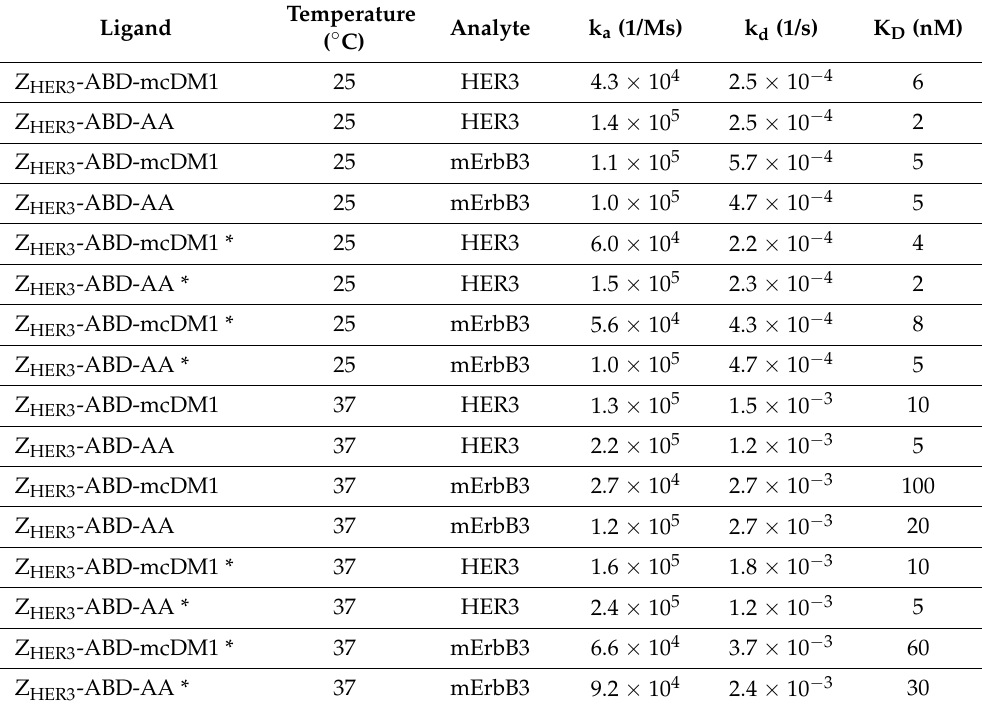
Table 1. Affinity between the constructs and HER3 and mErbB3, analyzed by a real-time